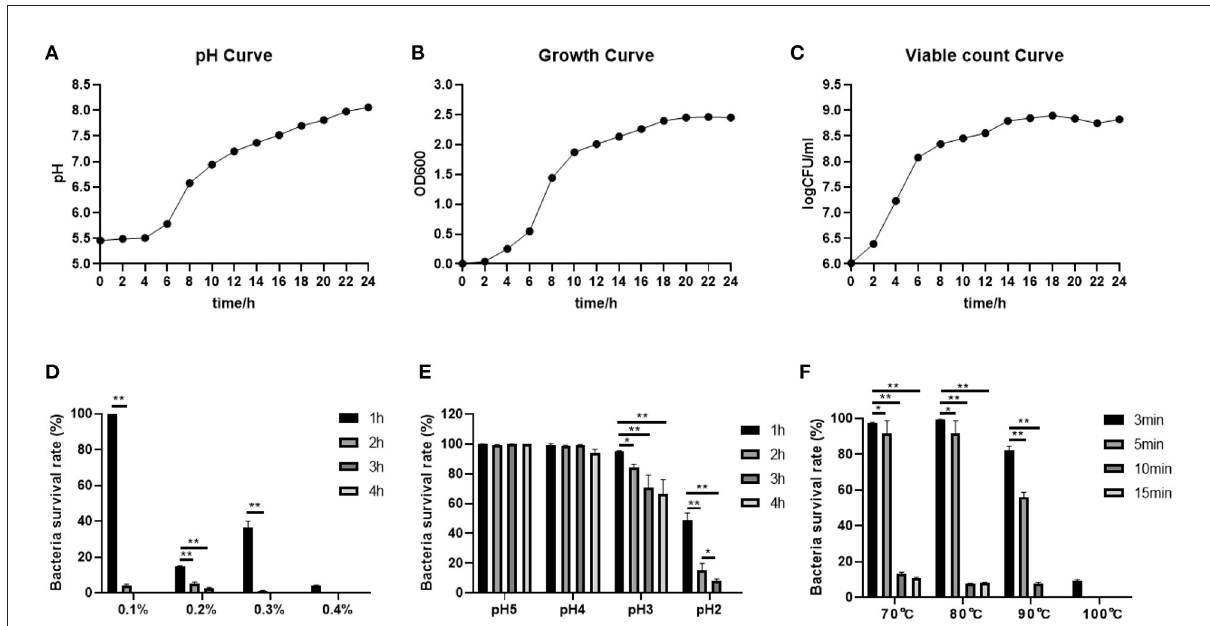
FIGURE2 Probiotic properties of B. subtilis M6. (A–C) The pH curve, growth curve and viable count curve of B. subtilis M6 . (D) The ability of bile salt tolerance of B. subtilis M6 . (E) The ability of acid tolerance of B. subtilis M6 . (F) The temperature sensitivity of B. subtilis M6 . n = 6. * P < 0.05; ** P <